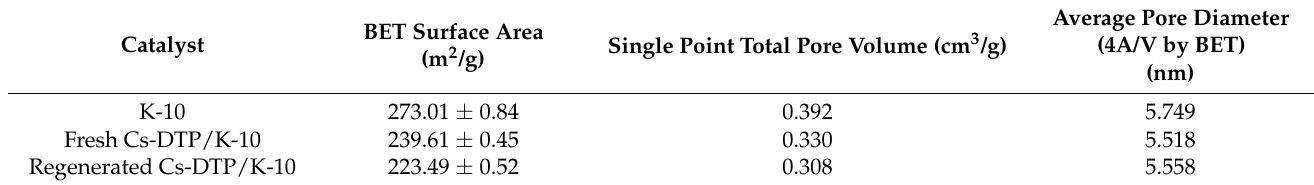
Table 1. Surface area, pore volume and pore diameter analysis.